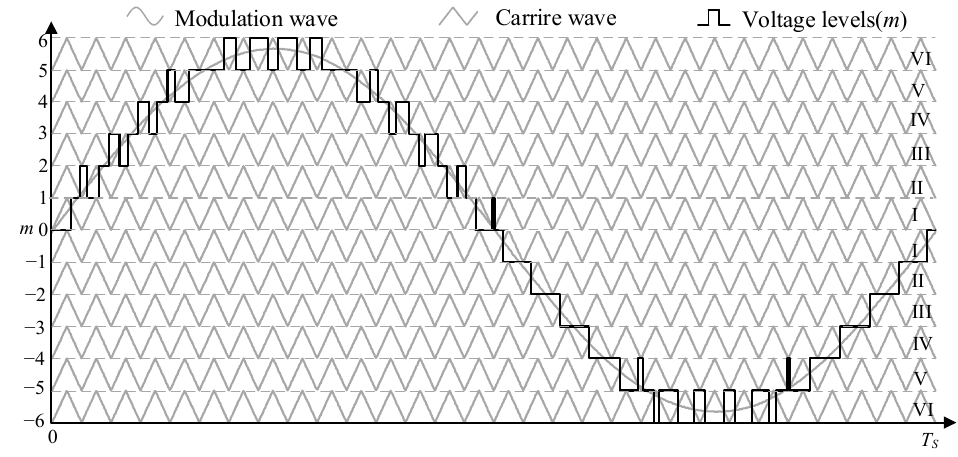
Figure 6. Carrier Cascaded Calculation for 3LNPC-CC.